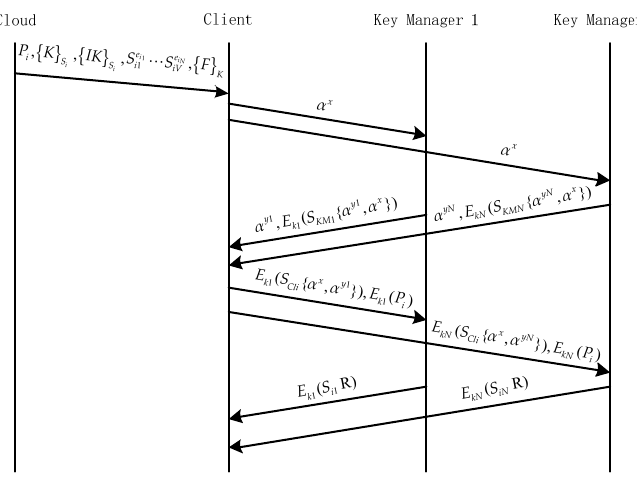
Figure 4. Multi-key manager DaSCE file download.